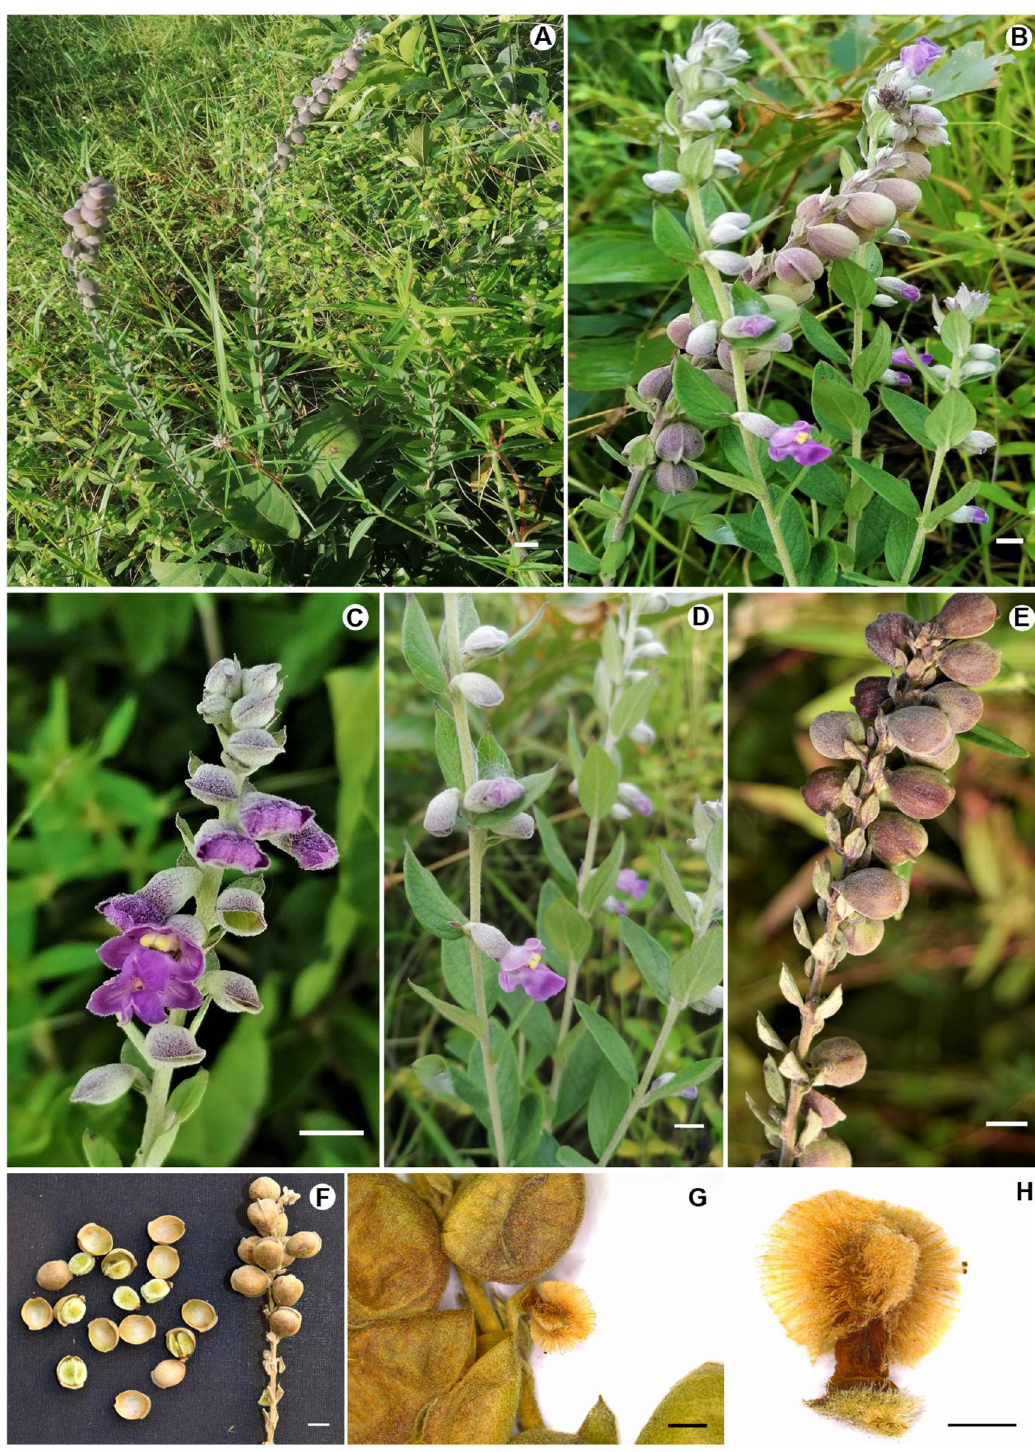
Fig 2. Morphological features of Tinnea gombea . (A) Plant habit and habitat; (B–D) young branches bearing vegetative and reproductive features; (E) Older branch with mature leaves, bracts and fruits; (G) closer view of dried fruits and leaves; (H) closer view of the fluffy seed with a tuft of basal hairs. Photos by D.A. Zhigila.